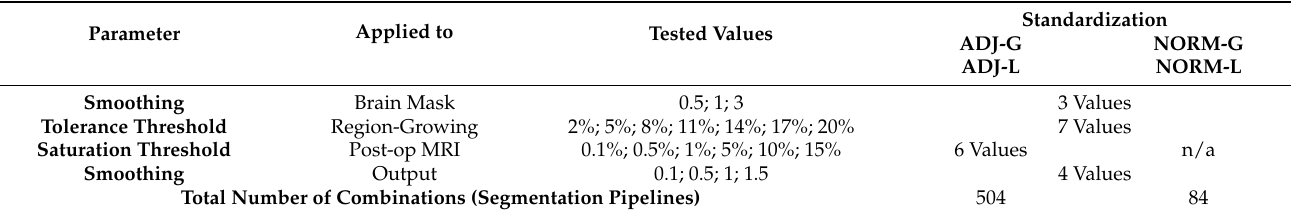
Table 1. Parameters and tested values.